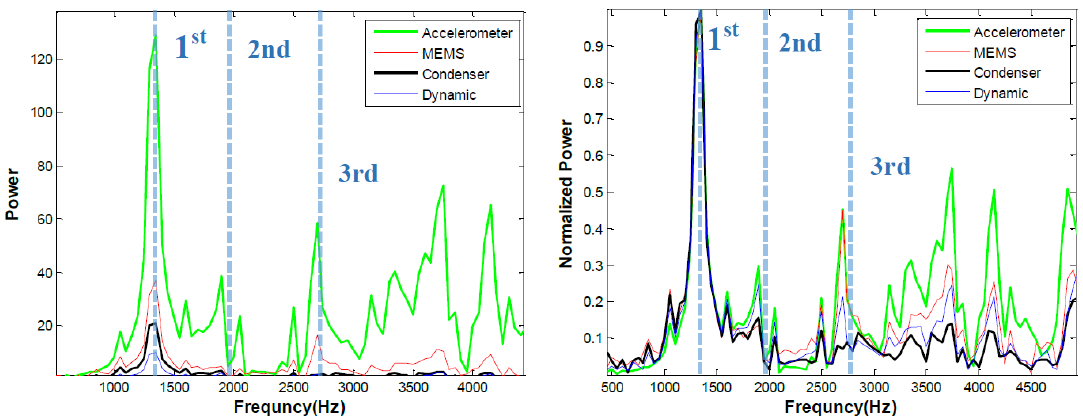
Figure 10. Impact echo time data collected above a 400 × 600 mm rectangular shallow delamination using different sensors; full signal ( left ) and first portion of signal ( right ).